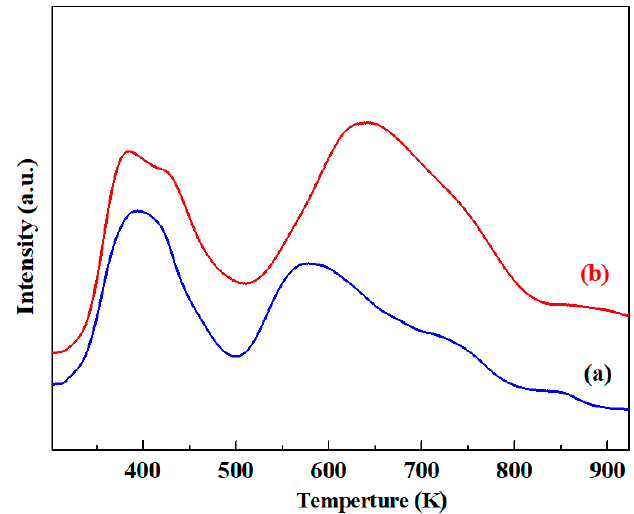
Figure 4. CO 2 -TPD profiles for catalyst samples: ( a ) Cu-Pd/ γ -Al 2 O 3 ; ( b ) Cu-Pd/(Mg) γ -Al 2 O 3.